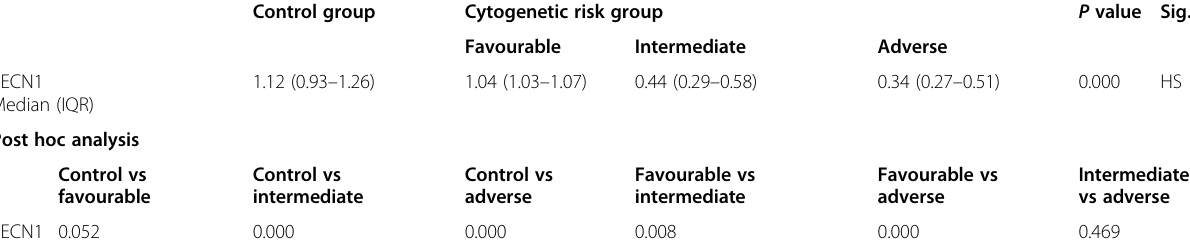
Table 3 Comparison between the control group and different cytogenetic risk groups regarding BECN1 gene expression Control